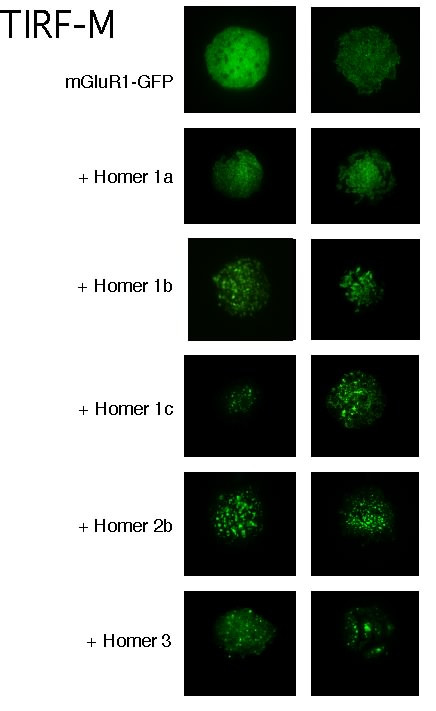
TIRF-M images of mGluR1-GFP fluorescence in SCG neurons expressing the receptor alone, "mGluR1-GFP", or with co-expression of the indicated Homer protein. Two representative neurons from each group are shown. The total number of neurons examined for each group were: mGluR1-GFP (19 cells), + Homer 1a (5), + Homer 1b (6), + Homer 1c (9), + Homer 2b (8), + Homer 3 (10).